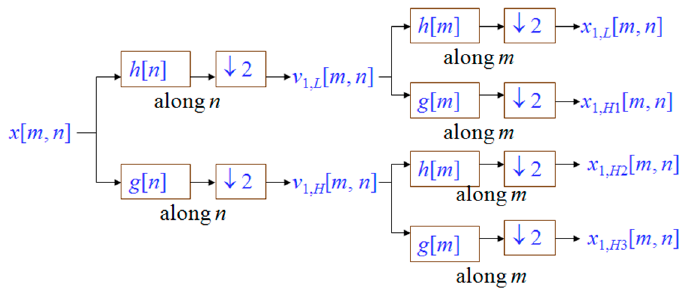
Figure 16. Architecture of the two-dimensional wavelet transform (from [57]).